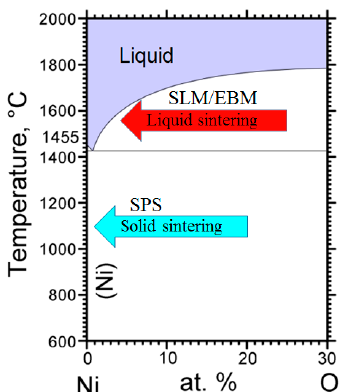
Figure 8. Ni–O binary phase diagram shows oxygen solubility in nickel at high temperatures, in which the temperatures for SPS and SLM/EBM are marked, respectively.